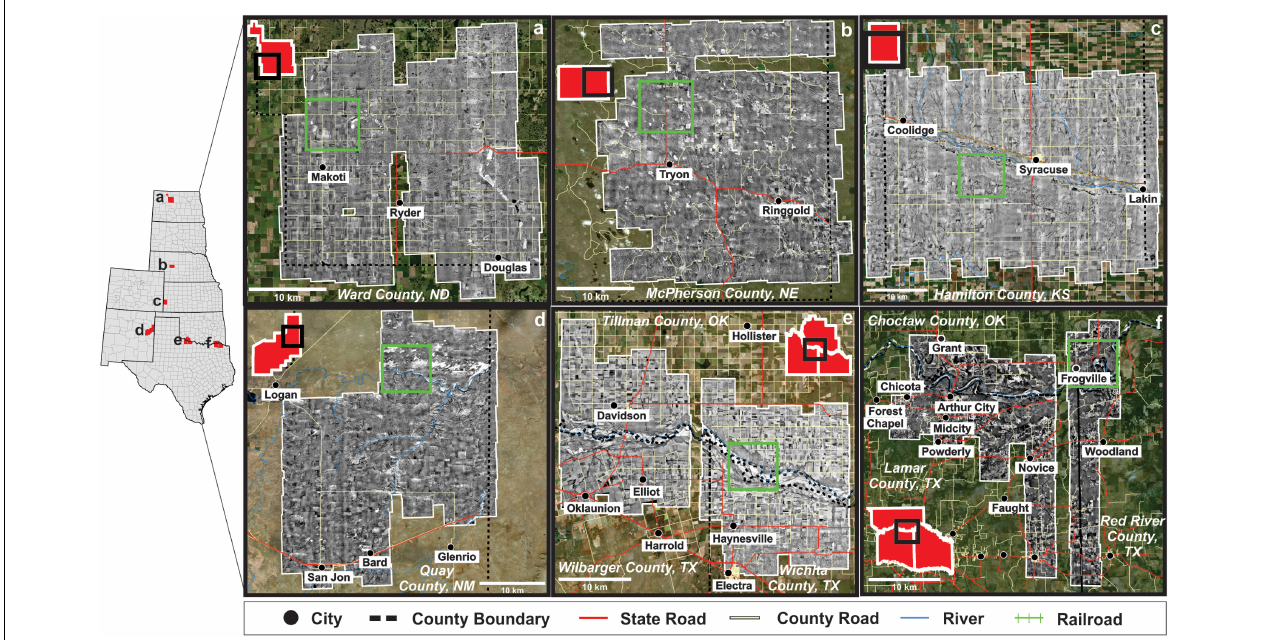
FIGURE 6 | Location map of selected areas showing county position on the Great Plains and extent of aerial photographic coverage reproduced for this study in: (a) Ward County, ND, (b) McPherson County, NE, (c) Hamilton County, KS, (d) Quay County, NM, (e) Tillman County, OK, Wilbarger and Wichita Counties, TX, and (f) Choctaw County, OK, Lamar and Red River Counties, TX. Survey details for the mosaics are presented in Table 2 . The green box denotes location of imagery shown in Figure 7